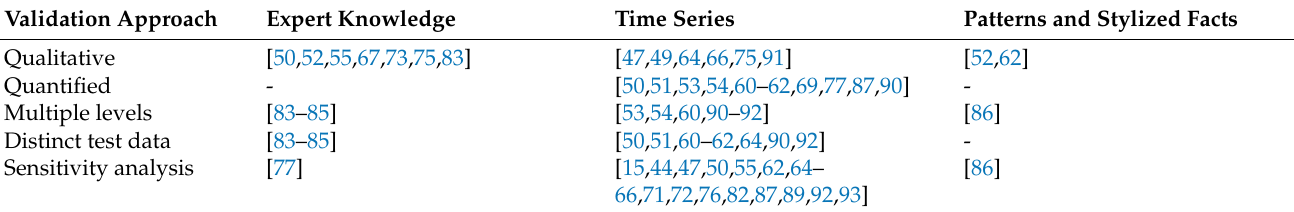
Table 9. Validation reported for the surveyed